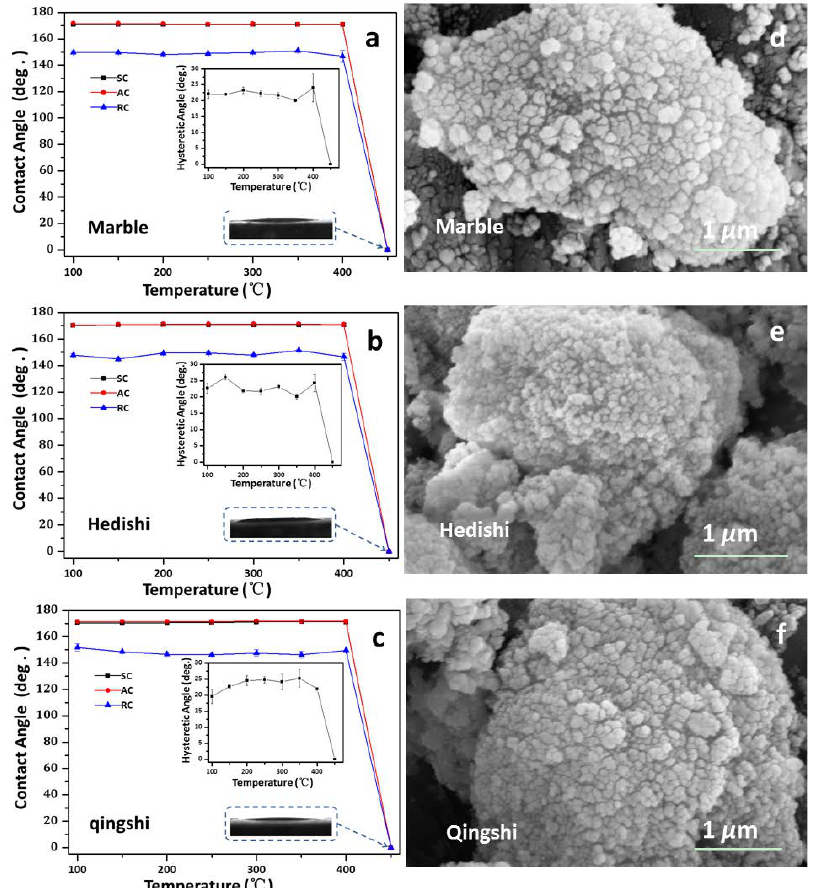
Figure 6. Variation of static, advancing, and receding water CAs with annealing temperature of the self-cleaning surfaces on marble ( a ), Hedishi ( b ), and Qingshi ( c ), and their SEM images ( d – f ) after annealing at 450 °C.